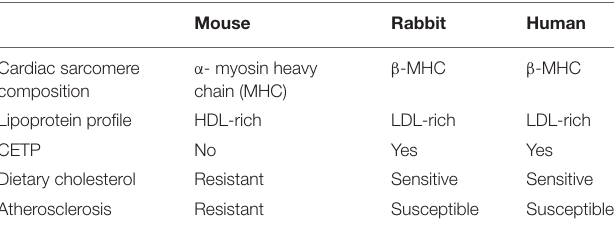
TABLE 1 | Comparison of selected parameters of cardiovascular physiology between mouse, rabbit, and human. Mouse Rabbit Human